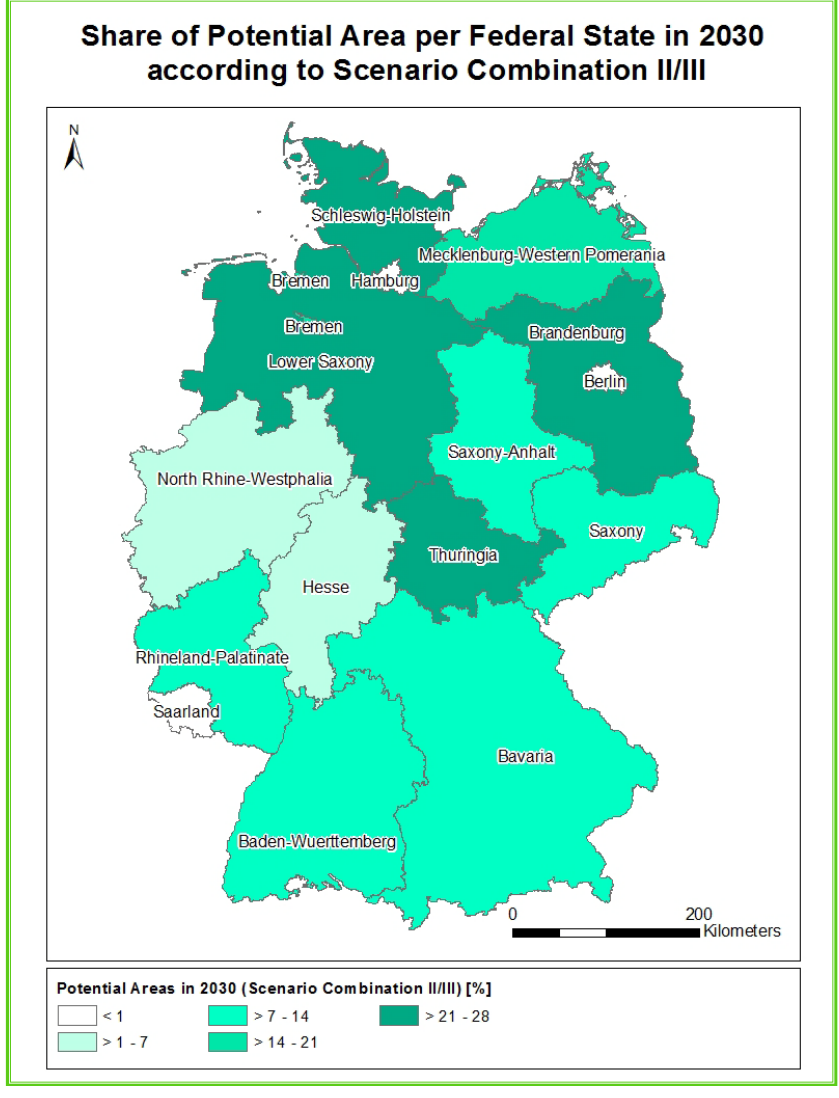
Figure 11. Potential areas in 2030 according to scenario combination